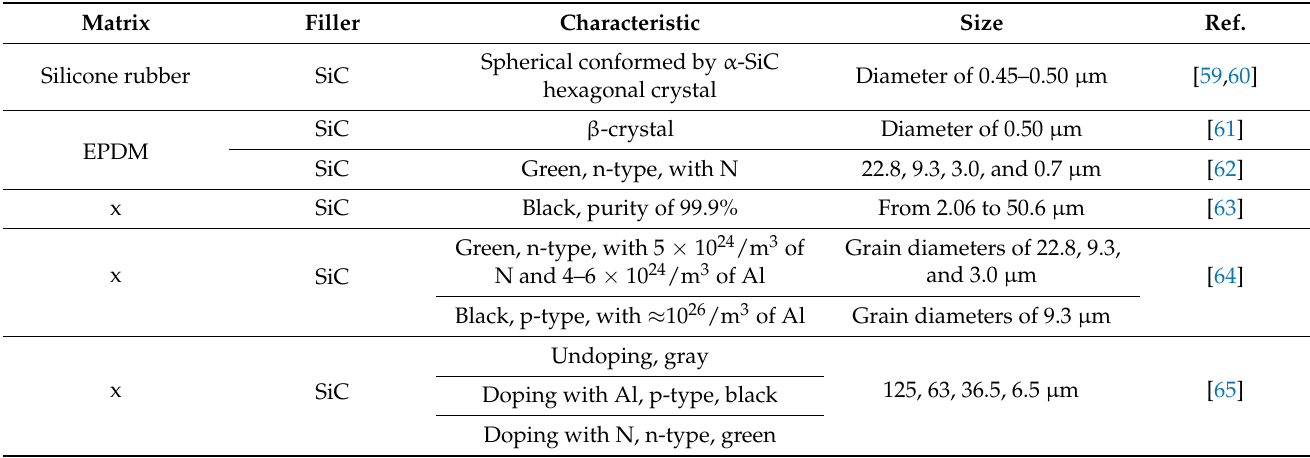
Table 2. Characteristics of SiC fillers used in nonlinear composites.